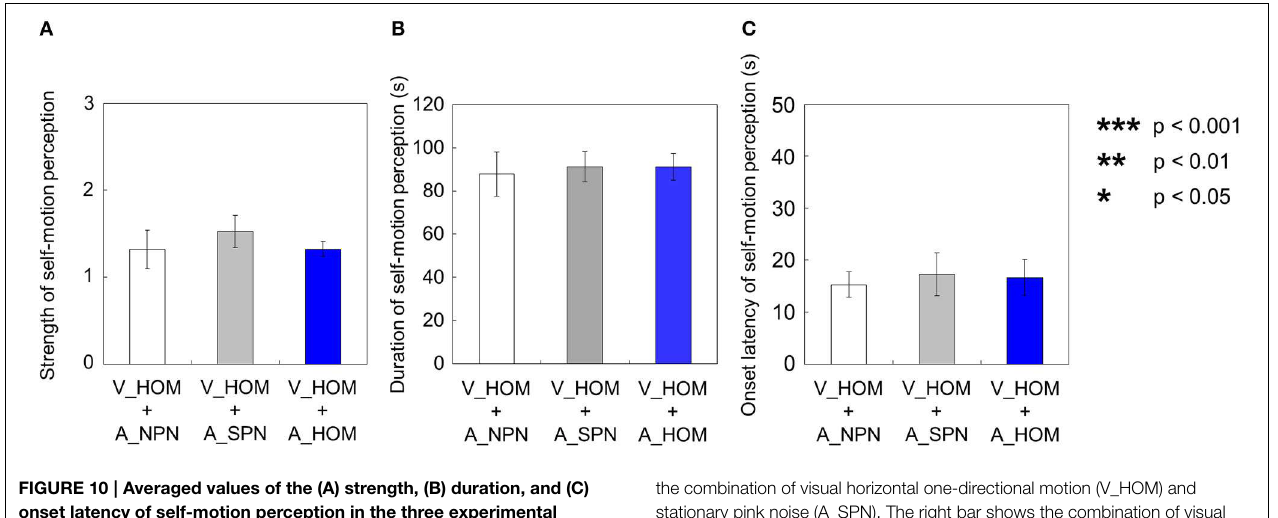
FIGURE 10 | Averaged values of the (A) strength, (B) duration, and (C) onset latency of self-motion perception in the three experimental conditions including one-directional visual rotation. In each graph, the left bar shows the condition combining visual horizontal one-directional motion (V_HOM) and no auditory stimulus (A_NPN). The middle bar shows